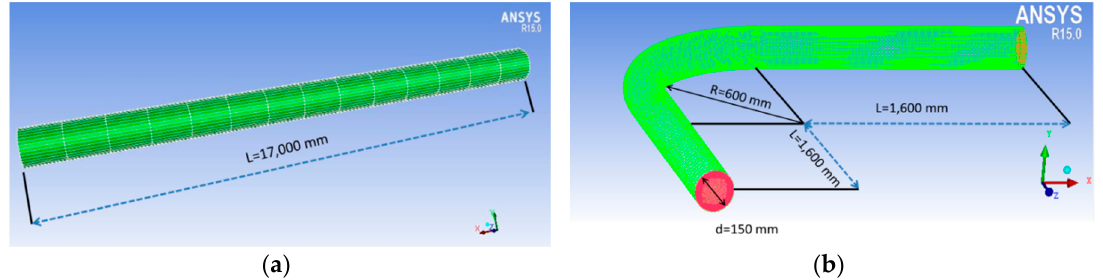
Figure 4. Geometry of the simulated pipe modes: ( a ) straight pipe; ( b ) 90° elbow pipe.